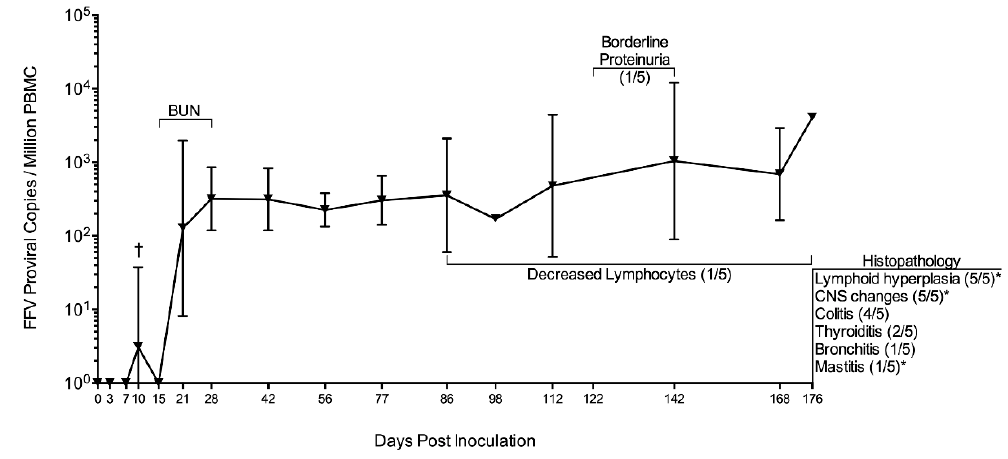
Figure 2. FFV proviral load in PBMC of cats FFV1-5 with summary of significant findings. FFV-infected cats began showing PBMC provirus 21 days pi. Cat FFV5 was re-inoculated and its timeline adjusted to match the rest of the cohort; this cat showed FFV positivity on day 10 post-reinoculation ( † ) [10]. Blood urea nitrogen (BUN) was significantly increased in infected cats compared to naïve on days 15, 21, and 28. Cat FFV3 had decreased lymphocytes compared to the rest of its cohort, which was negatively correlated to proviral PBMC load (Results Section 3.3). FFV3 also had borderline proteinuria on days 122 and 142 pi. Histopathological changes found after necropsy on day 176 are shown at the right-hand margin. Graph shows mean of FFV group cats’ FFV proviral load with bars denoting standard deviation. Numbers in parenthesis indicate number of cats out of the FFV cohort showing findings, with an asterisk (*) indicating findings also observed in control cat N4 to a lesser severity. Table 2. Summary of findings for diagnostic assays used in the experimental inoculation experiments. Bold font indicates that at least one cat was positive for the measured value, or differences in values between naïve and FFV-infected animals were significant. Cat FFV5 was on a different inoculation and sample collection schedule following re-inoculation on day 53 pi (Figure 1).